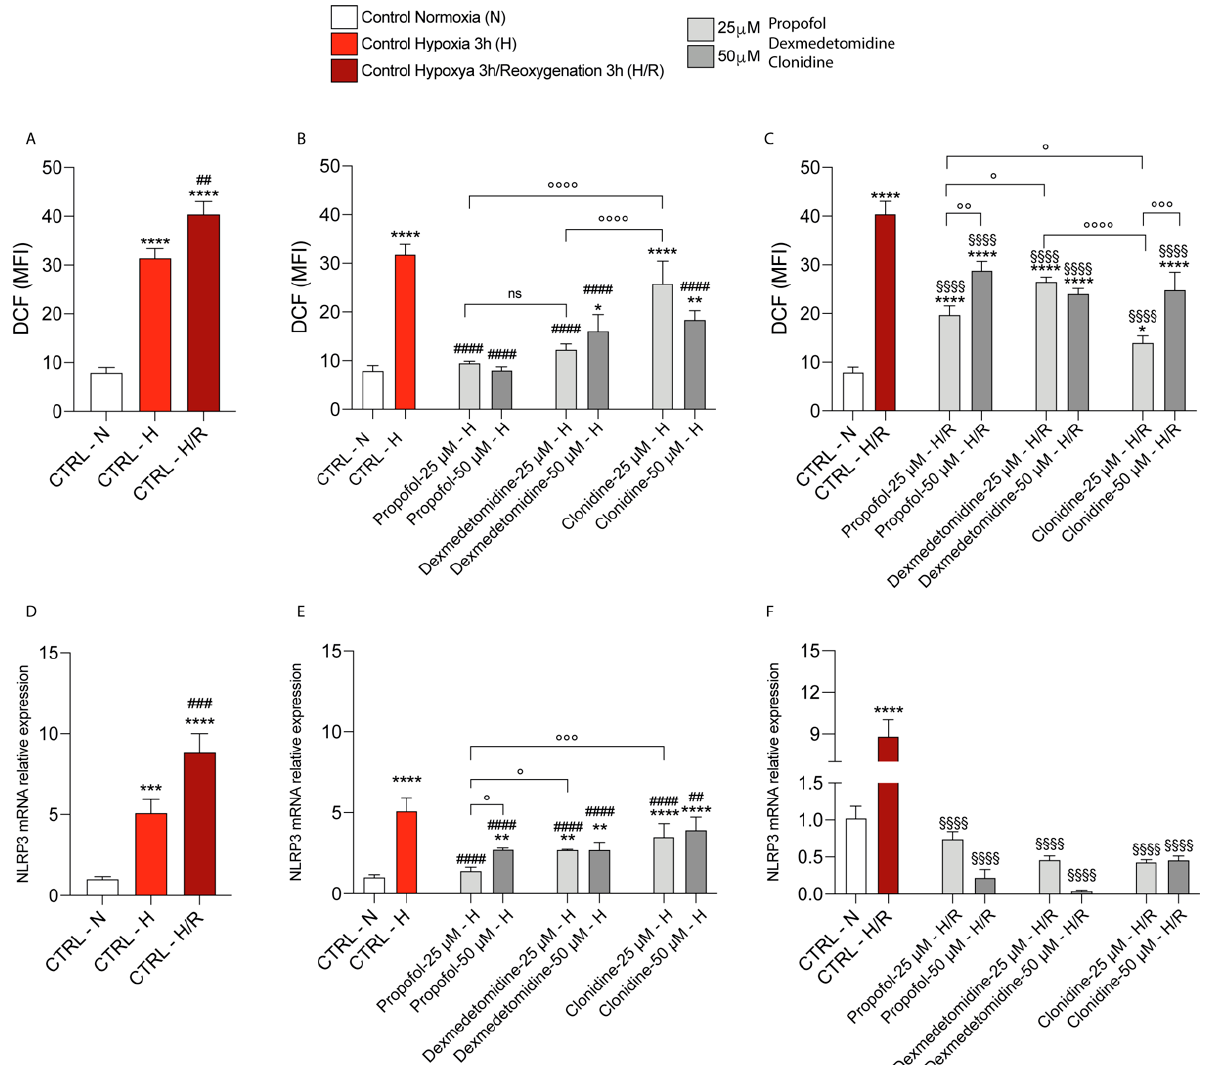
Figure 1. Effect of hypoxia and reoxygenation ( A ) on ROS production in microglia cells. Effect of Propofol, Dexmedetomidine, and Clonidine on ROS production after 3 h of Hypoxia ( B ) and 3 h of Reoxygenation ( C ), analyzed by flow cytometric assay. Data are expressed as mean ± SD of at least four independent experiments. * vs. Untreated Normoxia; (* p < 0.05; ** p < 0.005; *** p < 0.001; **** p < 0.0001); # vs. Untreated Hypoxia; ( ## p < 0.005; ### p < 0.001; #### p < 0.0001) § vs. Untreated Reoxygenation ( §§§§ p < 0.0001) ° vs. the different drugs (propofol vs. dexmedetomidine; propofol vs. clonidine; dexmedetomidine vs. clonidine) (° p < 0.05; °° p < 0.005; °°° p < 0.001; °°°° p < 0.0001). Effect of Hypoxia and Reoxygenation on NLRP3 mRNA expression in ( D ) Untreated cells, and Propofol, Dexmedetomidine, and Clonidine treated cells ( E , F ), analyzed by real-time PCR. The calculated value of 2 − ∆∆ Ct in untreated controls is 1. Data are expressed as mean ± SD of at least four independent experiments. * vs. Untreated Normoxia ( ** p < 0.005; *** p < 0.001; **** p < 0.0001); # vs. Untreated Hypoxia ( ## p < 0.005; ### p < 0.001; #### p < 0.0001); § vs. Untreated Reoxygenation ( §§§§ p < 0.0001); ◦ vs. the different drugs (propofol vs. dexmedetomidine; propofol vs. clonidine; dexmedetomidine vs. clonidine) ( ◦ p < 0.05; ◦◦◦ p <